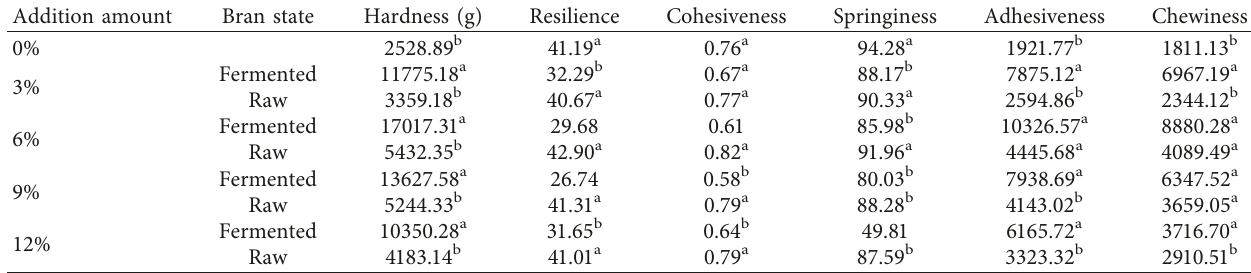
Figure 6: The effect of bran addition on the color of steamed Table 3: Different amounts of added bran and the texture of mixed steamed bread.